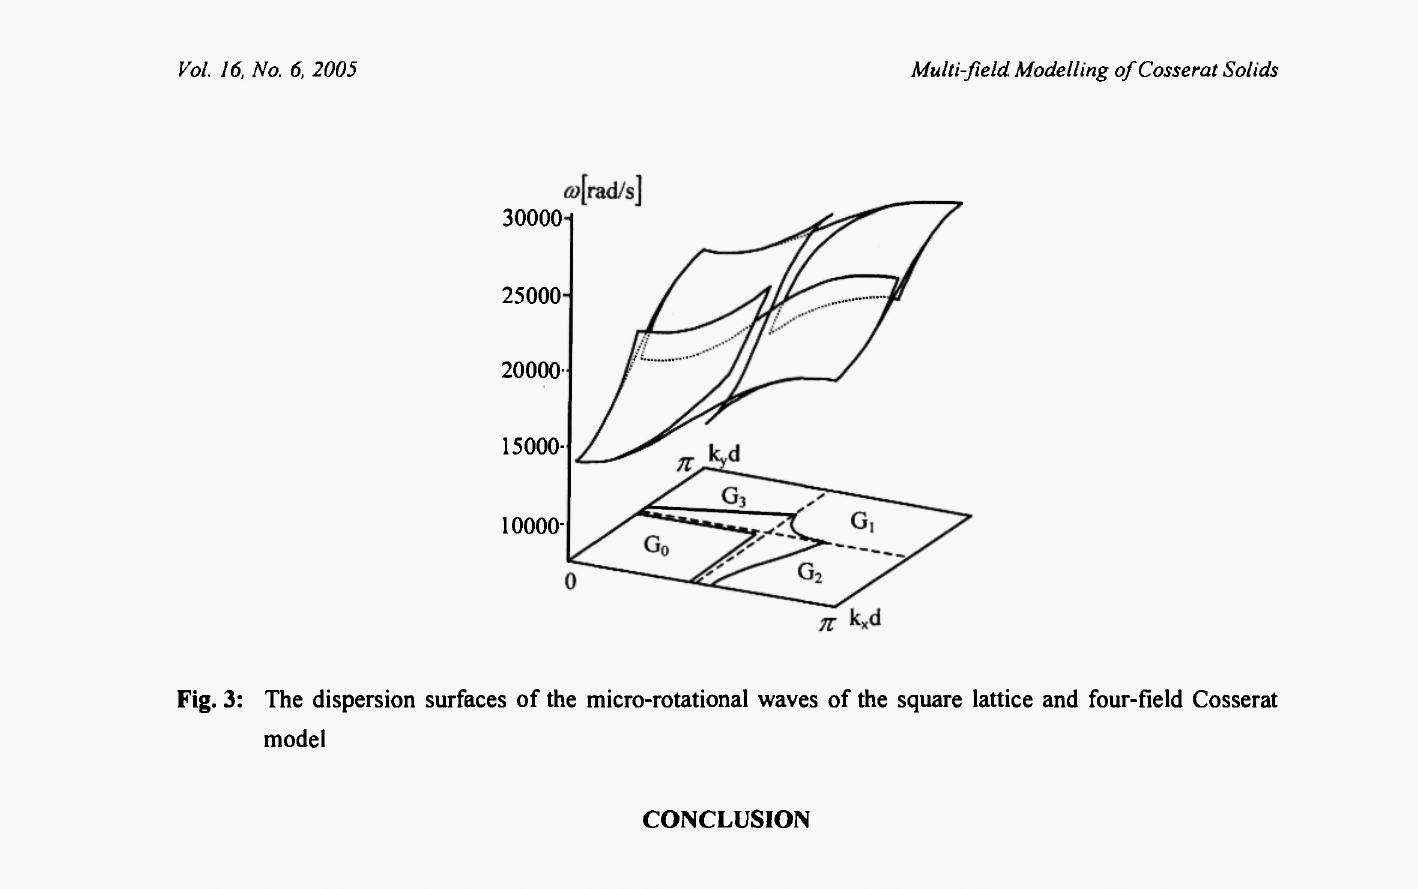
Fig. 3: The dispersion surfaces of the micro-rotational waves of the square lattice and four-field Cosserat